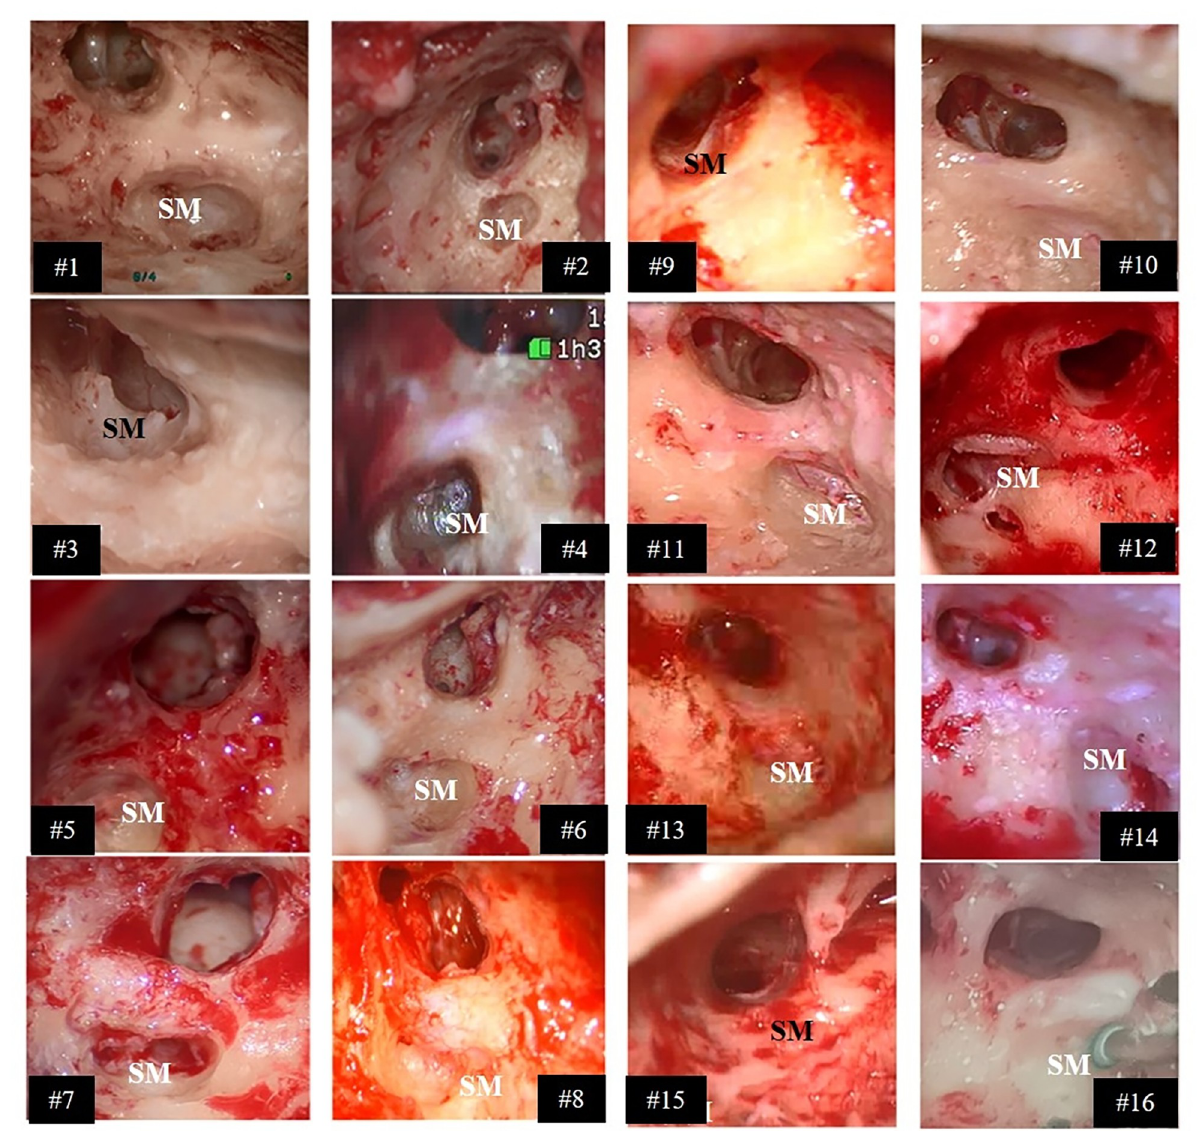
Fig 2. Access to the SM drilled on the sixteen patients. Screenshots taken from intraoperative microscope recordings. Patients #3, #9, and #15: anterior approach; all other patients: retrofacial approach. In #16, an electrostimulation probe is placed on the stapedius muscles.